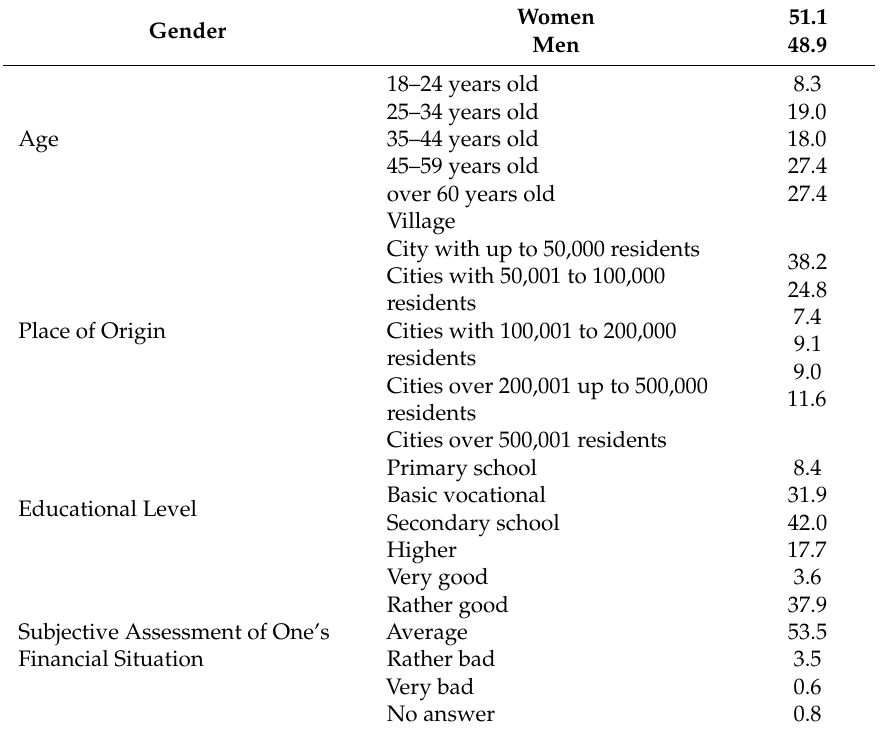
Table 1. Sociodemographic characteristics of consumer groups